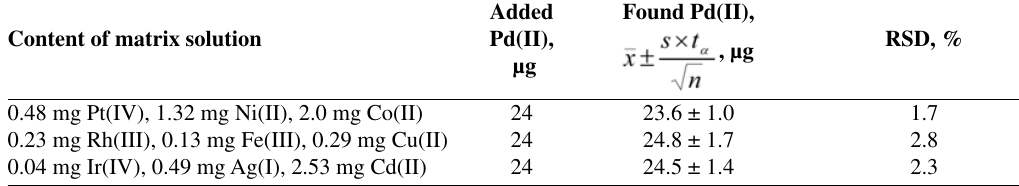
Table 3. Accuracy of the spectrophotometric determination of Pd(II) with ITHBA in model solutions, n = 3; P = 0.95 Added